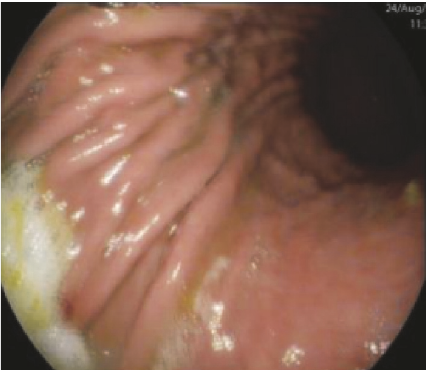
Figure 3: Greater curvature of the stomach.